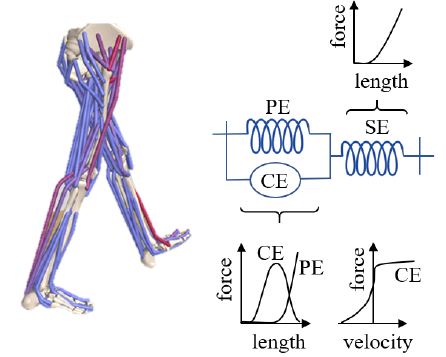
Figure 2. Hill-type muscle models consist of contractile elements (CE), parallel elastic elements (PE), and series elastic elements (SE). Depending on the length and velocity of the contractile element, it produces contractile forces proportional to the excitation signal. Passive elements act as non-linear springs with length-dependent